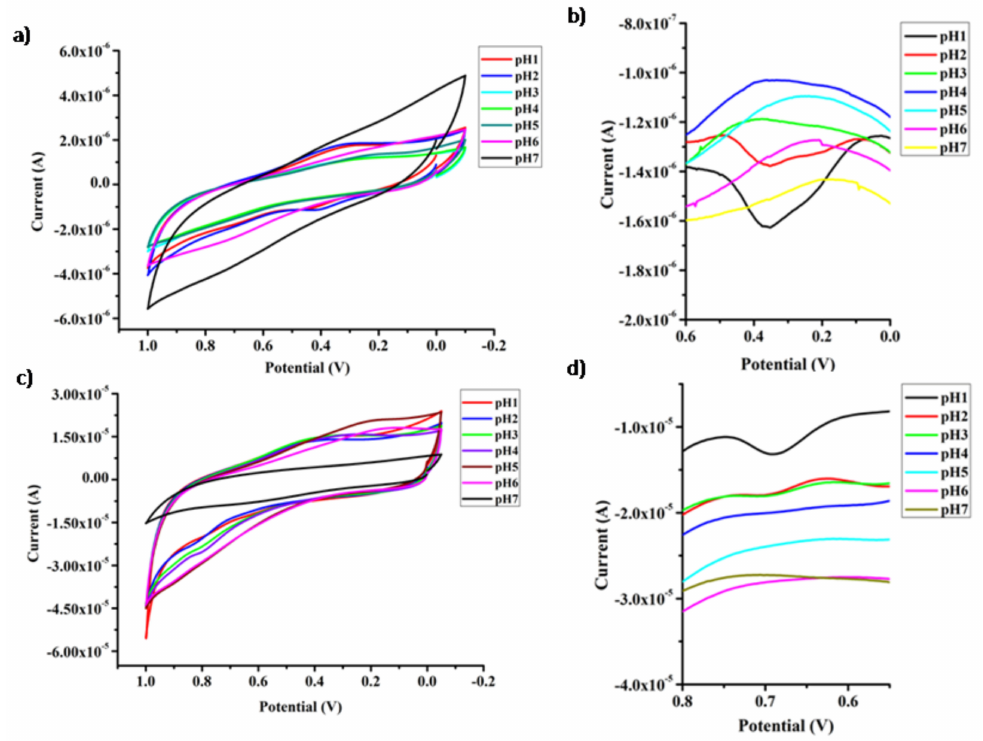
Figure 6. Cyclic voltammogram of 3% CNOs–PS / Pt electrode for ( a ) Cys (10 − 3 M) and ( c ) Met (10 − 3 M) at di ff erent pHs; ( b , d ) are DP voltammograms of 10 − 3 M Cys and Met, respectively, at a scan rate of 0.1 V /